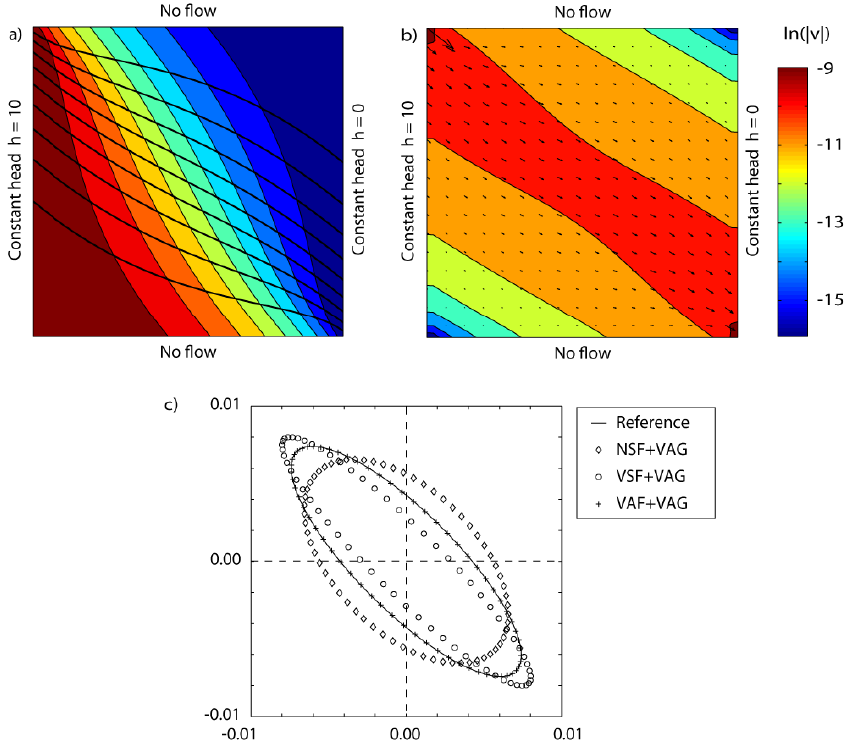
Figure 15. Illustration of the head field ( a ) and velocity field ( b ) in a homogeneous anisotropic medium (sample K1) computed with permeameter type boundary conditions (PRM). The medium is homogeneous, as K 1 , but it has been chosen here with a different orientation to better illustrate the distortion of the flow field. Its main axis of anisotropy in this figure is inclined at – 45 degrees, 𝐾 𝑚𝑎𝑥 = 10 −4 , 𝐾 𝑚𝑖𝑛 = 10 −5 . Anisotropy ellipses are shown below in plot ( c ). These ellipses represent the square root of flux directional permeability √𝐾 𝑓𝑙𝑢𝑥 [77] obtained here with the NSF, VSF, and VAF criteria. The ellipses axes are aligned with the principal directions of anisotropy, and their principal radii are the square roots of the principal values of conductivity.